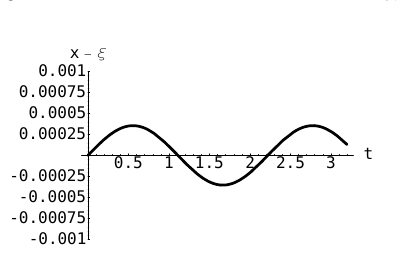
Figure 4. Difference between neigh- boring solution and trivial solution